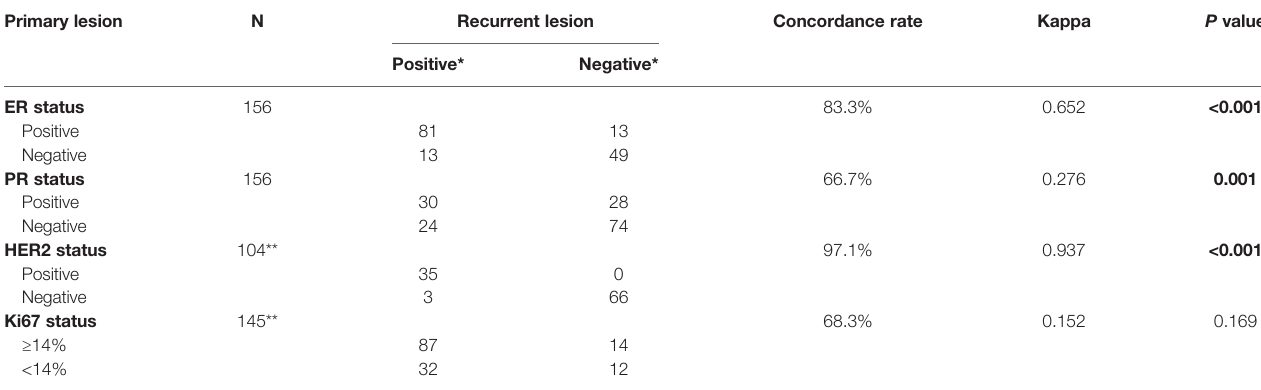
TABLE 2 | Concordance rate of biomarkers between primary and recurrent/metastatic breast cancer lesions.